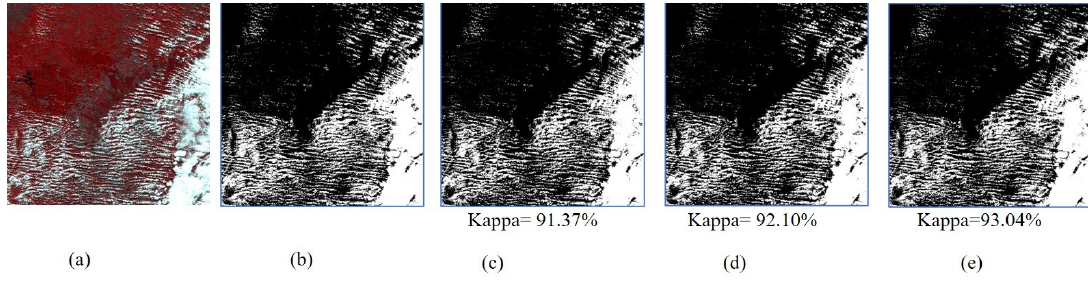
Figure 9. ( a ) NIR-R-G image, ( b ) ground truth, and masks generated by ( c ) U-Net, ( d ) NC, and ( e )